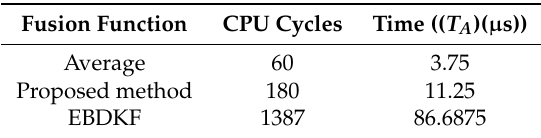
Figure 21. Network Lifetime comparison of three different fusion techniques for an ad hoc-type network. CPU overhead of different information fusion functions for randomly placed non-hierarchical